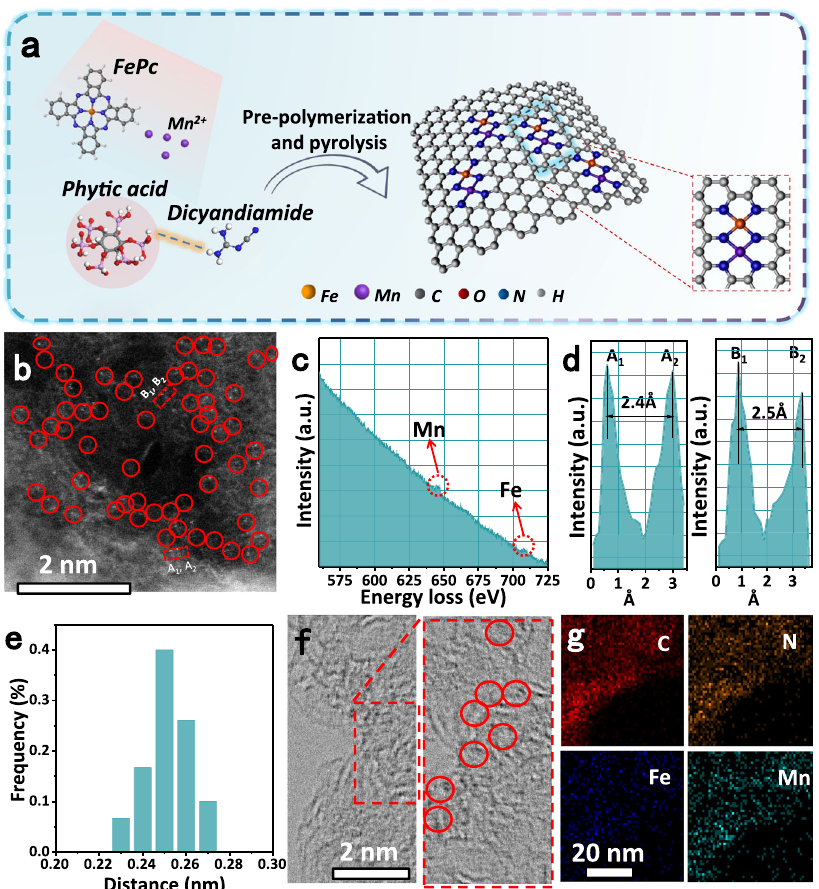
Fig. 1 Synthetic illustration and TEM characterizations of Fe,Mn/N – C catalyst. a Schematic illustration of synthesis procedure for Fe,Mn/N – C catalysts. b Aberration-corrected HAADF-STEM image and some of bimetallic Fe/Mn sites are highlighted by larger red circles. c Fe,Mn/N – C structure analyzed by EELS. d The intensity pro fi les obtained on two bimetallic Fe – Mn sites. e Statistical Fe – Mn distance in the observed diatomic pairs. f HR-TEM of Fe,Mn/N – C, in which some lattice distortions are highlighted by red circles. g HAADF-STEM image of Mn, Fe/N – C with mappings of individual elements (C, N, Fe, and